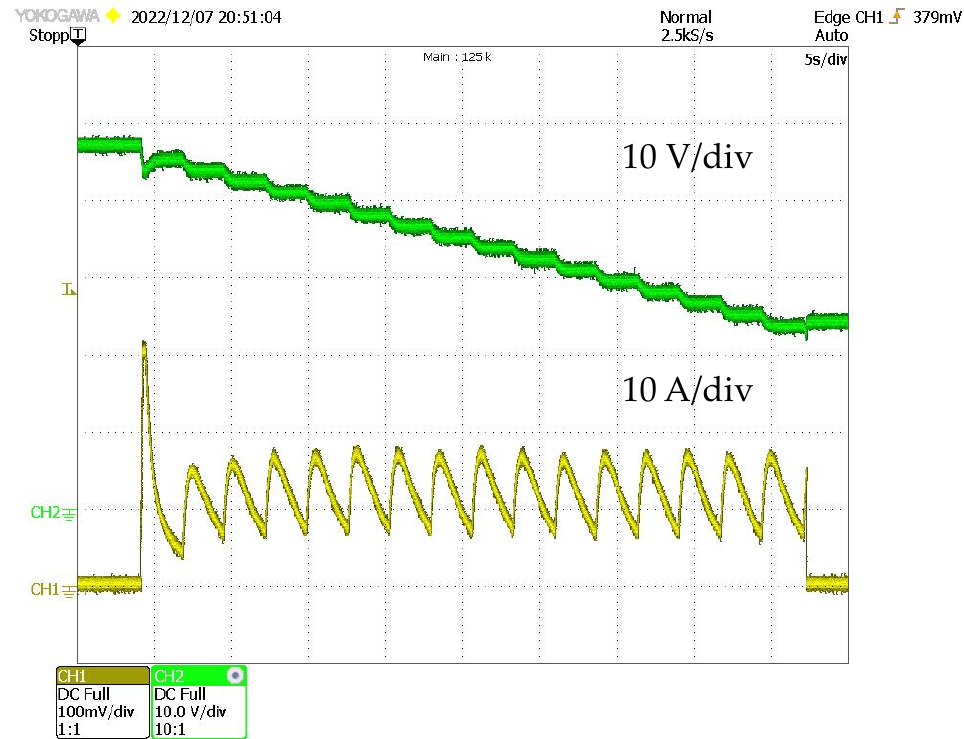
Figure 46. Experimentally obtained diagrams of discharging current and voltage.